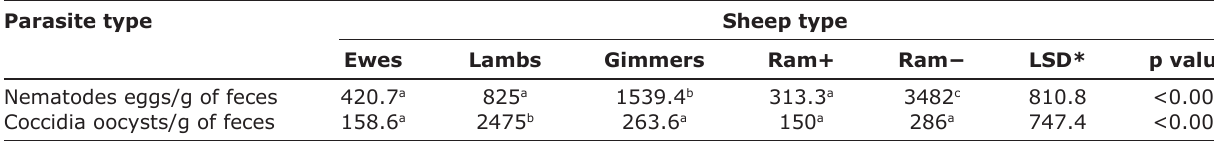
Table-3: Prevalence and burden of nematodes ova and coccidia oocysts of sheep in Ayeduase. Parasite type